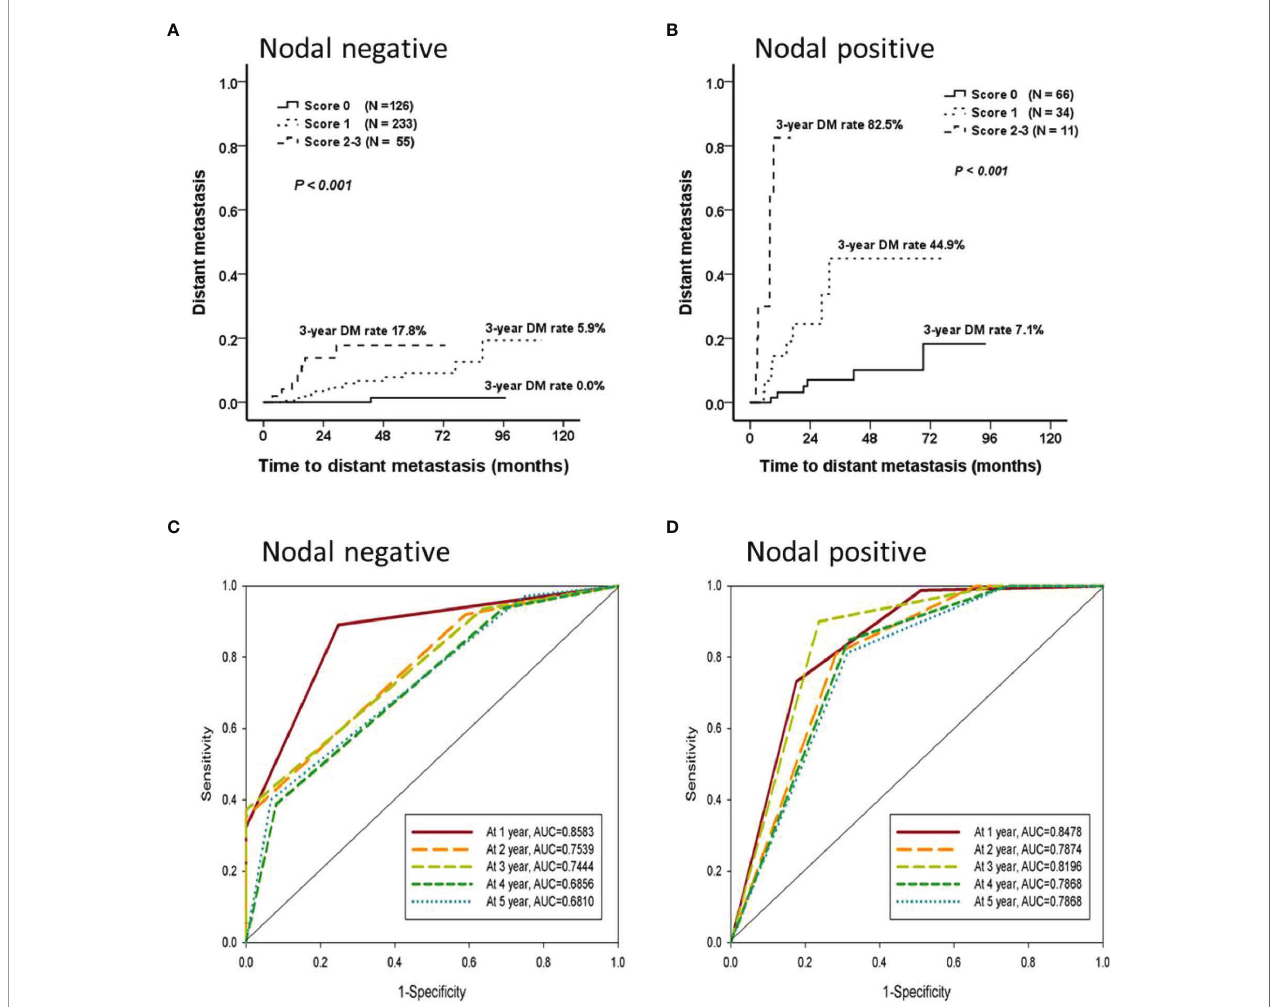
FIGURE 4 | The prediction model for distant metastasis. Cox forward stepwise regression analyzes were used to identify the independent factors for the time until DM. Age, surgical margin, and early locoregional recurrence were predictors of DM that were independent of time until DM in the nodal-negative group; the lymphocyte-to-monocyte ratio, presence of lymphovascular invasion, and early locoregional recurrence in the nodal-positive group were determined. Each independent factor was scored 1 point, and two predictive models could classify patients from both the nodal-negative and -positive groups into low- (score 0), intermittent- (score 1), or high- (score 2 or 3) risk groups separately. (A, B) The nodal-negative and -positive 3-y DM rates were 0.0%, 5.9%, and 17.8% and 7.1%, 44.9%, and 82.5%, respectively. (C, D) These models were effective predictors of DM events occurring within the fi rst 3 y. The areas under the curve (AUCs) of the nodal-negative and -positive models were 0.744 and 0.820,